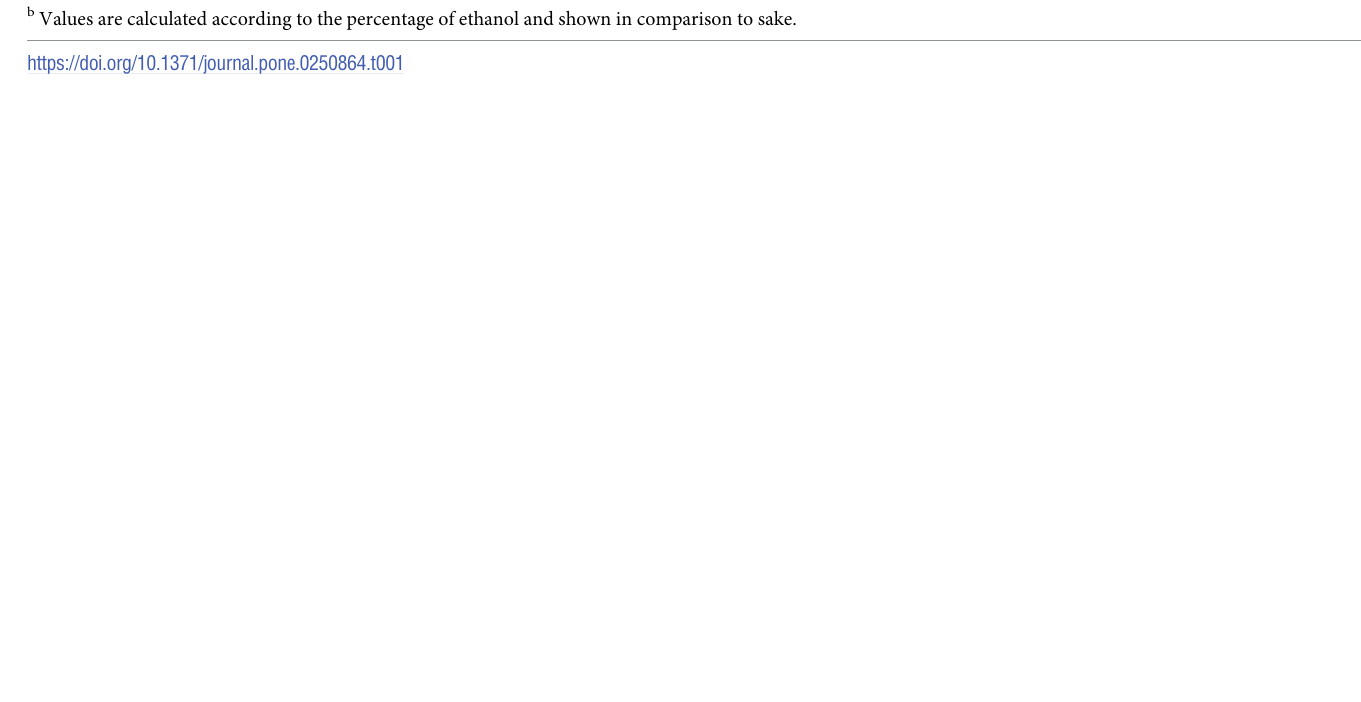
FFQ, food frequency questionnaire. a Values are presented as mean and 10 th -90 th percentiles in parentheses. b Values are calculated according to the percentage of ethanol and shown in comparison to